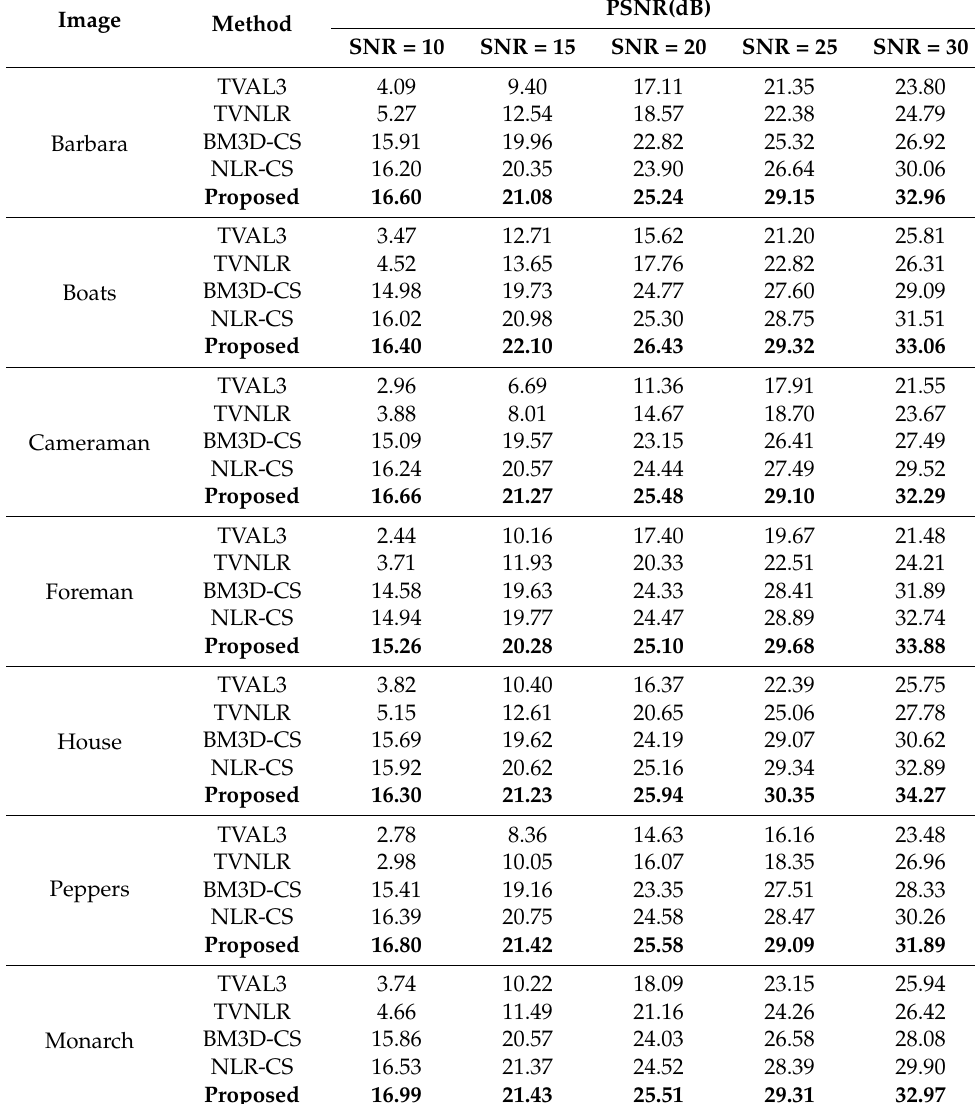
Table 2. The PSNR (dB) of test images reconstructed at 20% sampling rate from noisy measurements (SNR = 10, 15, 20, 25, 30 dB). The best performance algorithm is shown in bold.